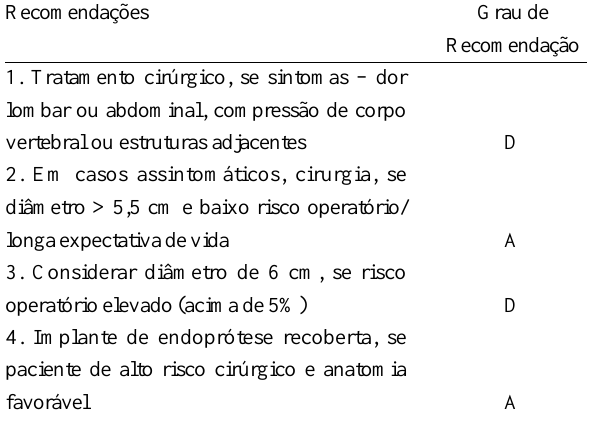
REFERÊNCIAS 1. Daily PO, Trueblood HW, Stinson EB, Wuerflein RD, Schumway NE. Management of acute aortic dissections. Ann Thorac Surg. 1970;10(3):237-47. 2. Wolfe WG, Moran JF. The evolution of medical and surgical management of acute aortic dissection. Circulation. 1997;56(4 pt 1):503-5. 3. Jamieson WR, Munro Al, Miyagishima RT, Allen P, Tyers FG, Gerein AN. Aortic dissection: early diagnosis and surgical management are the keys to survival. Can J Surg. 1982;25(2):145-9.